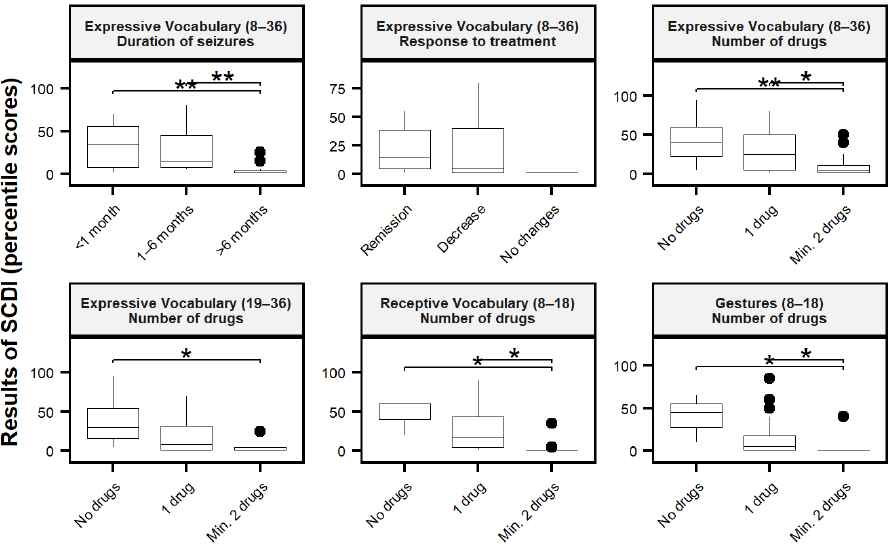
Figure 1. Quartile distribution of statistically significant results: duration of seizures, response to treatment, and the number of drugs. The Y axis indicates the SCDI percentile score. On the X axis, there are names of groups of individual variables. * p < 0.05, ** p < 0.01 range.